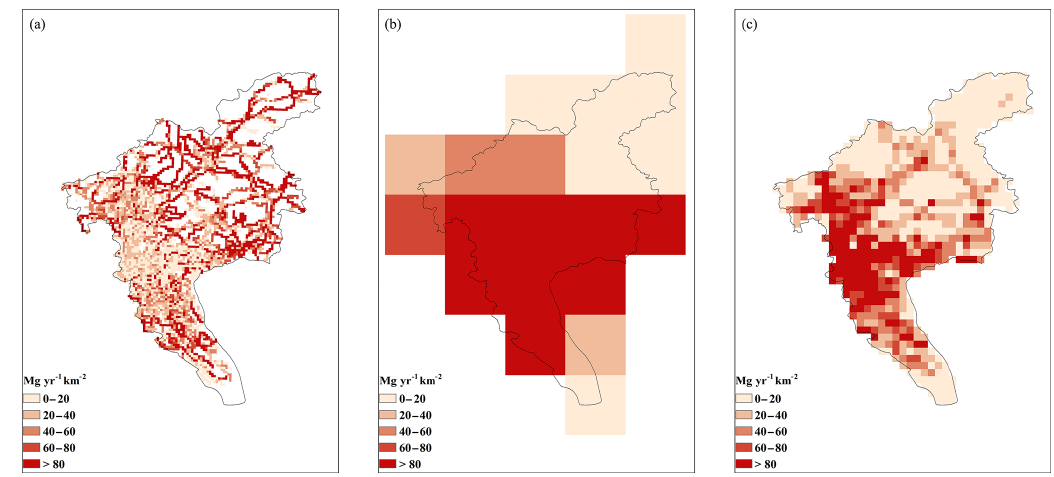
Figure 10. Spatial distribution of CO from (a) ROE model, (b) MEIC-2016, and (c) PRD-2015 in